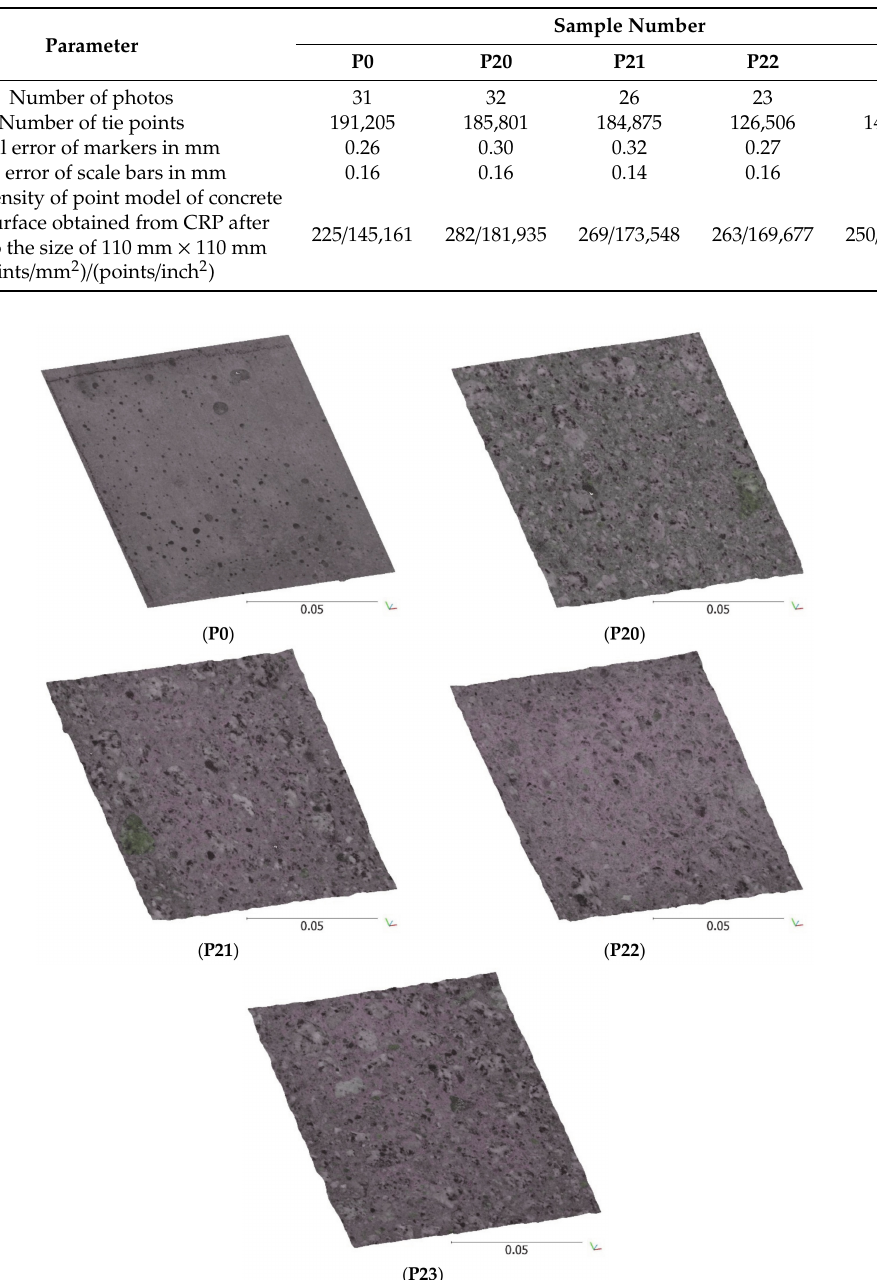
Figure 14. The perspective view of the segments of point clouds obtained from CRP as models of concrete surfaces for samples P0, P20, P21, P22 and P23 (the scale bars are given in